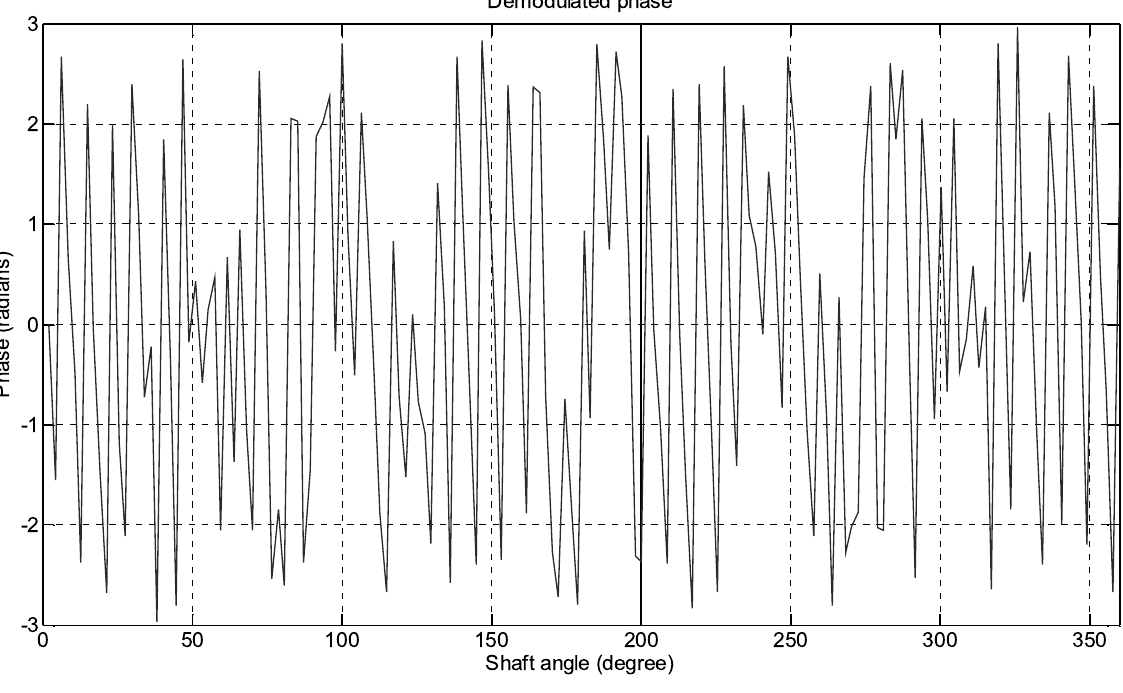
Fig. 18. Phase diagram of the residual signal in the 7th harmonic for 5% fault.